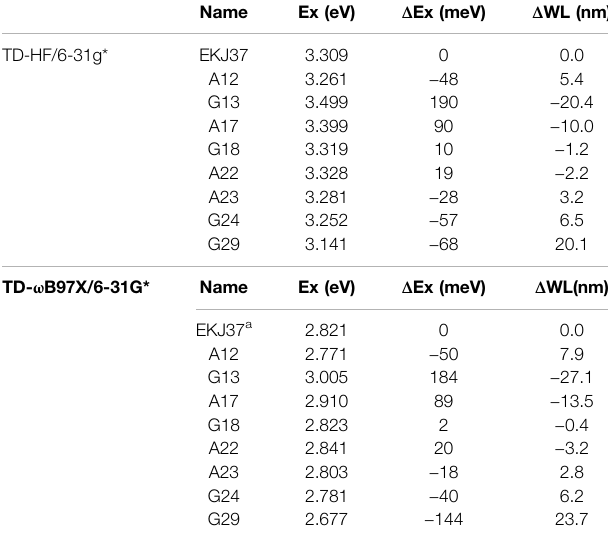
TABLE 3 | Contributions of the ribonucleotides in close contact with the fl uorophore to the calculated excitation energy predicted by the GMFCC approach, based on 10 snapshots extracted from the 100-ns MD simulation. The calculations were performed at the TD-HF/6-31G* and TD- ω B97X/6- 31G*levels, respectively. “ Ex ” isthecalculated excitation energy (in eV)for the fl uorophore molecule of EKJ37 or the two-body (2B) molecular species consisting of one ribonucleotide in RNA and EKJ37 (shown in ribonucleotide name in the table). “ Δ Ex ” represents the excitation energy difference between the two-body (2B) molecular fragment and EKJ37, and Δ WL represents the wavelength difference (in nm) converted from Δ Ex.